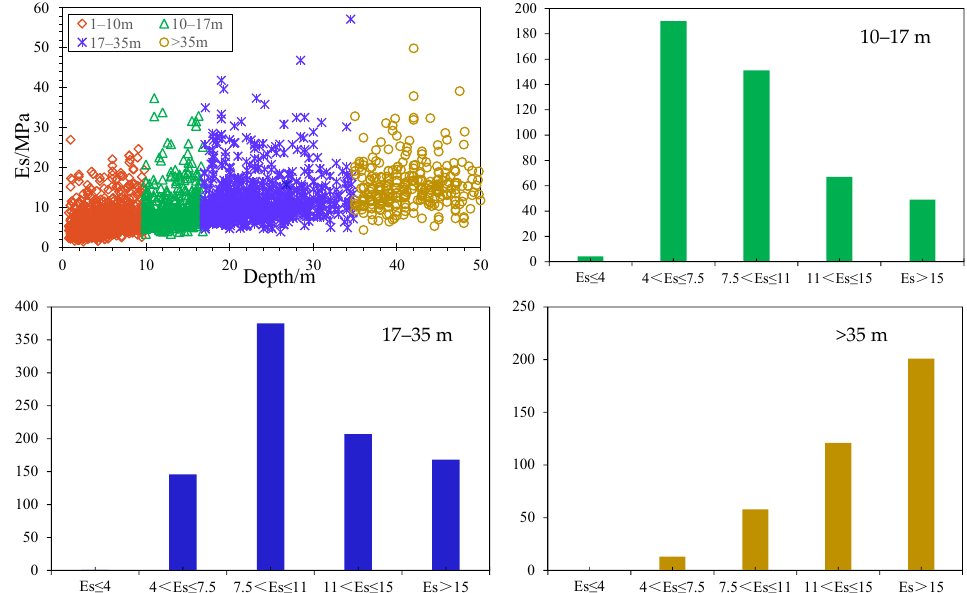
Figure 16. Diagrams of E s values and depth intervals (1–10 m, 10–17 m,17–35 m, and >35 m) in the study area.